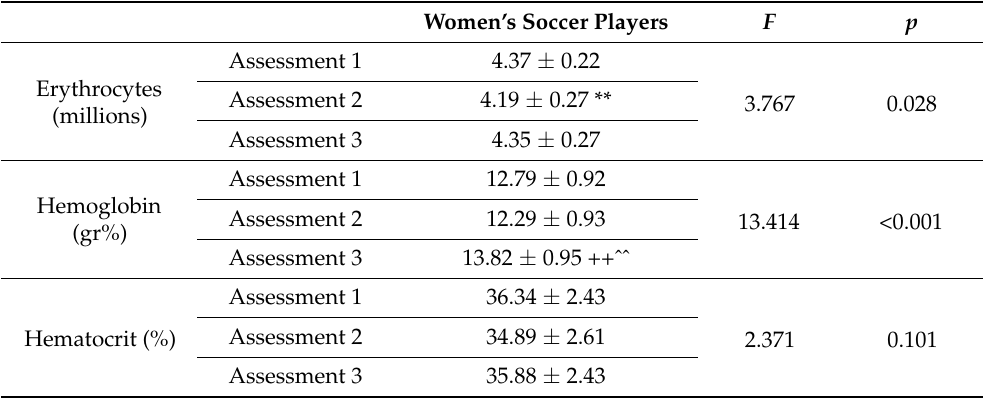
Table 6. Hematological parameters of Fe